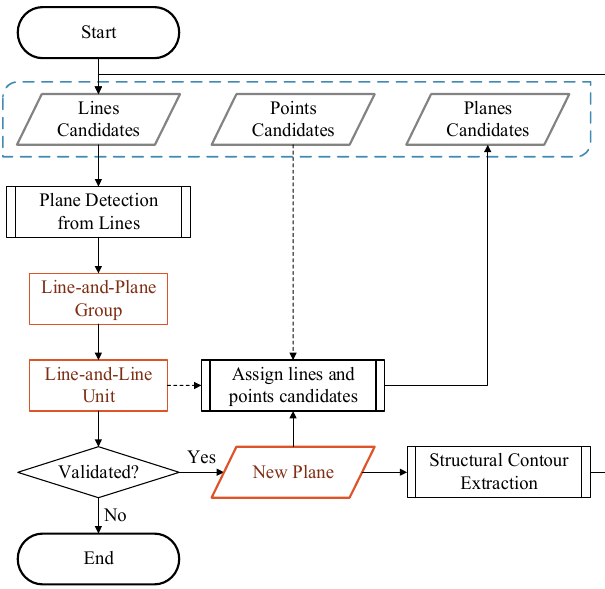
Figure 10. The workflow of the plane deduction.